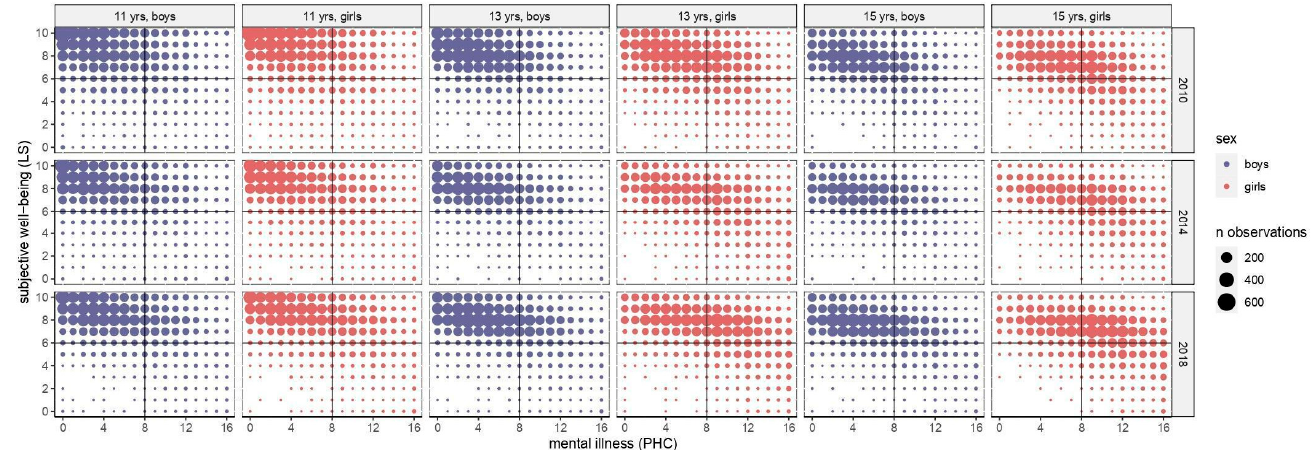
Figure 1. Distribution of observations in the Dual Factor Model frame across time. Stratification by gender and age. Abbreviations. LS: life satisfaction; PHC: psychological health complaints. Table 1. PHC and LS across surveys, stratified by gender and age ( N = 165,683). PHC and LS as continuous variables. Boys ( N = 83,020) Girls ( N =